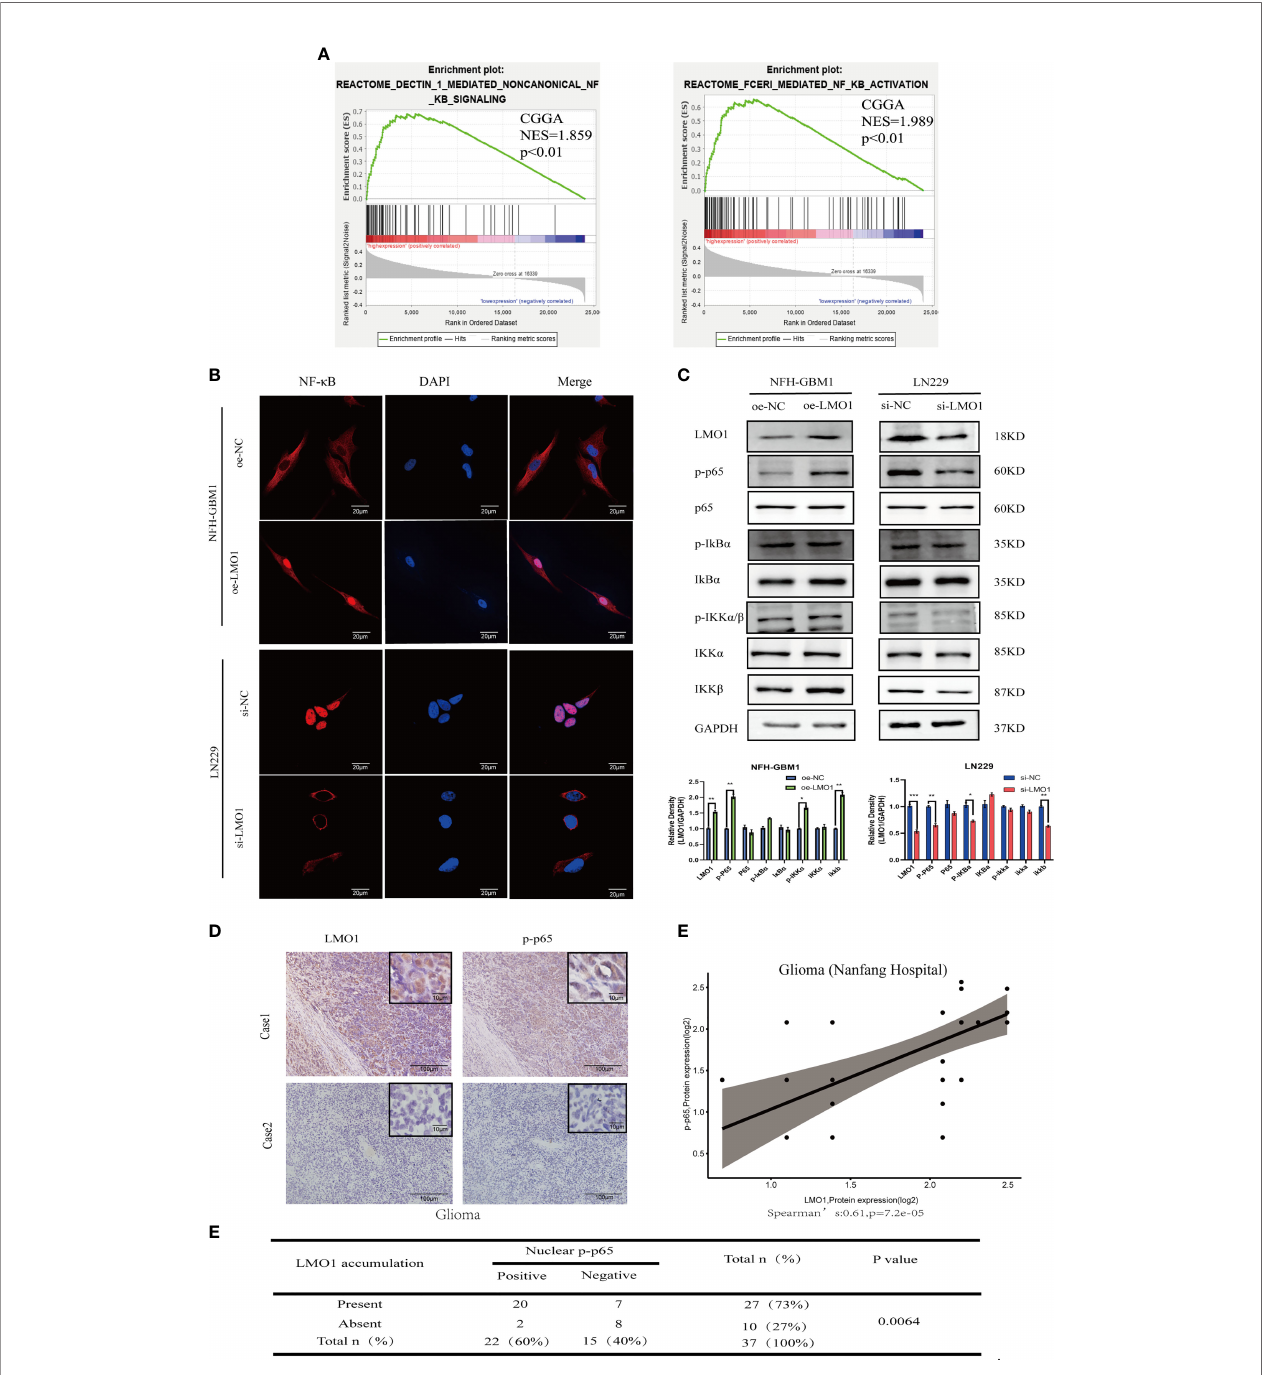
FIGURE 4 | LMO1 regulates the malignant biological behavior of glioma through the NF- k B pathway. (A) GSEA analysis showed that high expression of LMO1 was positively correlated with enhanced expression of the NF- k B pathway in CGGA datasets. (B) Subcellular localization of NF- k B p65 in the indicated cells as analyzed by an immunofuorescence staining assay.Scale bars=20 m m. (C) The protein expression of the downstream genes of the NF- k B pathway after LMO1 knockout or overexpression as measured by western blotting and gray quantitative analysis. Three biological replicates were performed. Student ’ s t test was used for statistical analysis. (D) Adjacent tumor sections from representative cases show LMO1 and p-p65 expression in human gliomas. Scale bars=100 m m (main images) and 10 m m (insets). (E) The protein expression of LMO1 and p-p65 is signi fi cantly positively correlated in the glioma tissue. (R=0.61, n= 37, p=7.2e-05). (F) The relationship between LMO1 and pp65 was analyzed by Spearman rank correlation test (p=0.0064). *p< 0.05. **p<0.01.